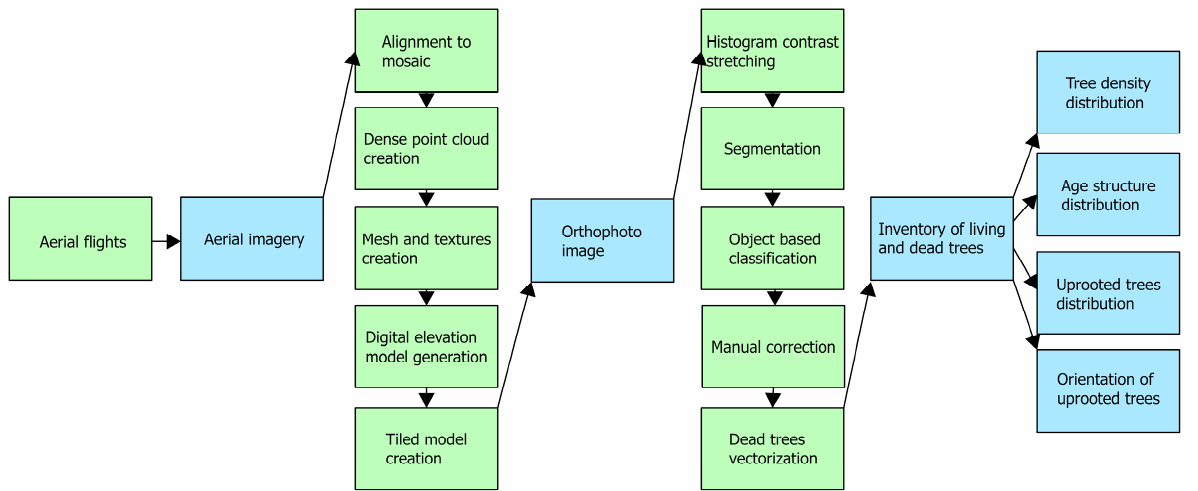
Figure 3. Flowchart describing methodological